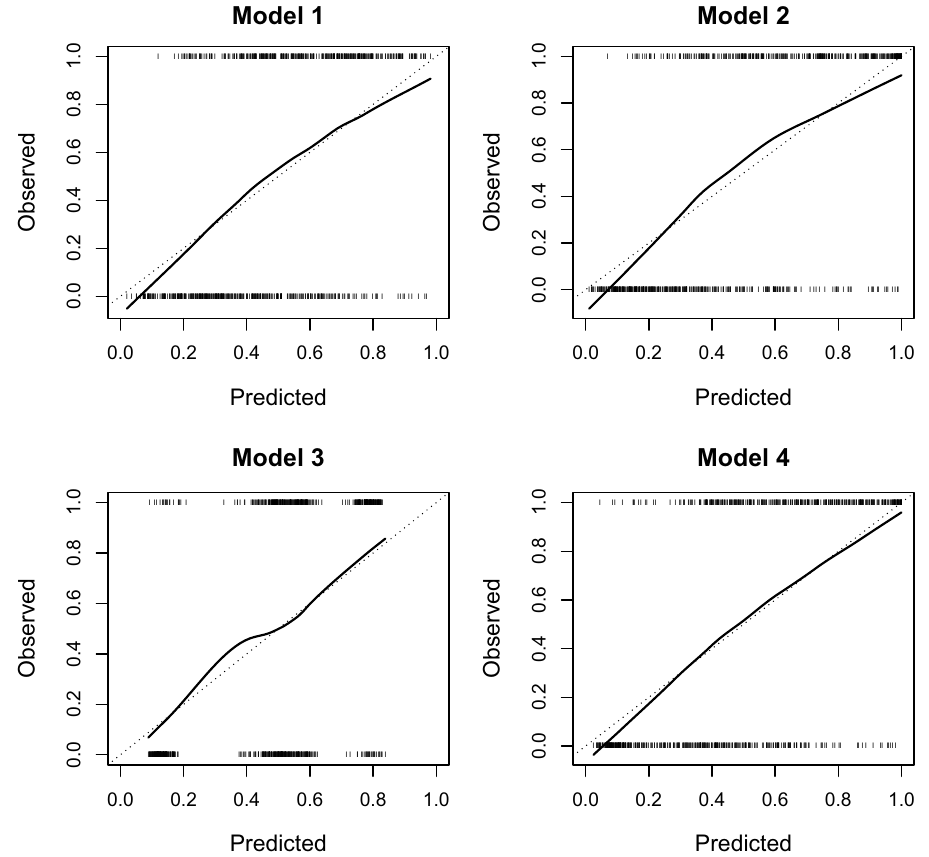
Figure 2. Calibration curves for models 1–4 from the validation sample. Plots of observed frequencies of insulin resistance (1 or 0) against predicted probabilities from the respective models. The ideal calibration curve is the bisector of the coordinate system (dashed